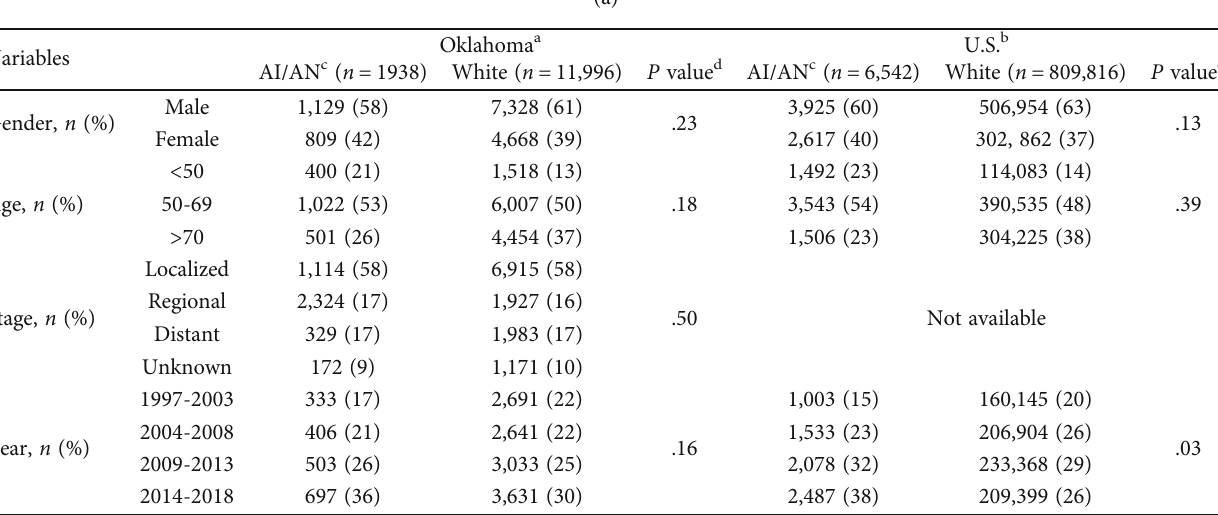
Table 1: Demographic characteristics of study participants ((a) incidence rate data and (b) mortality rate